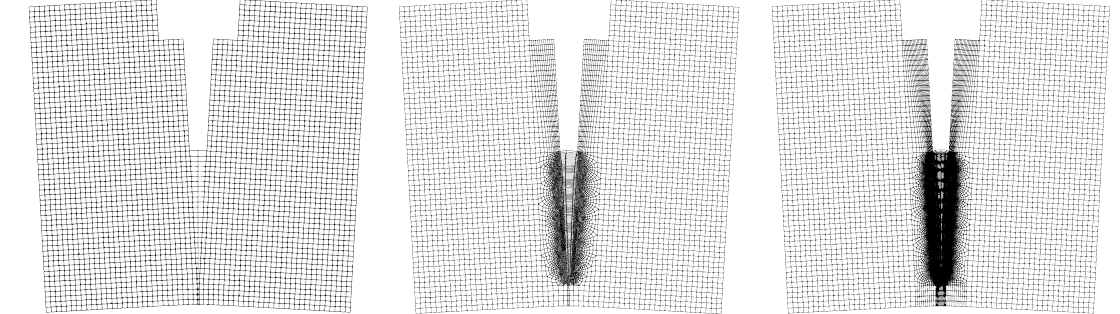
Figure 4. Deformed specimen at CMOD = 0.3mm with a displacement scale factor of 100 for the three structured finite element meshes: coarse—3580 elements ( left ), medium—6940 elements ( center ), and fine—15430 elements ( right ).